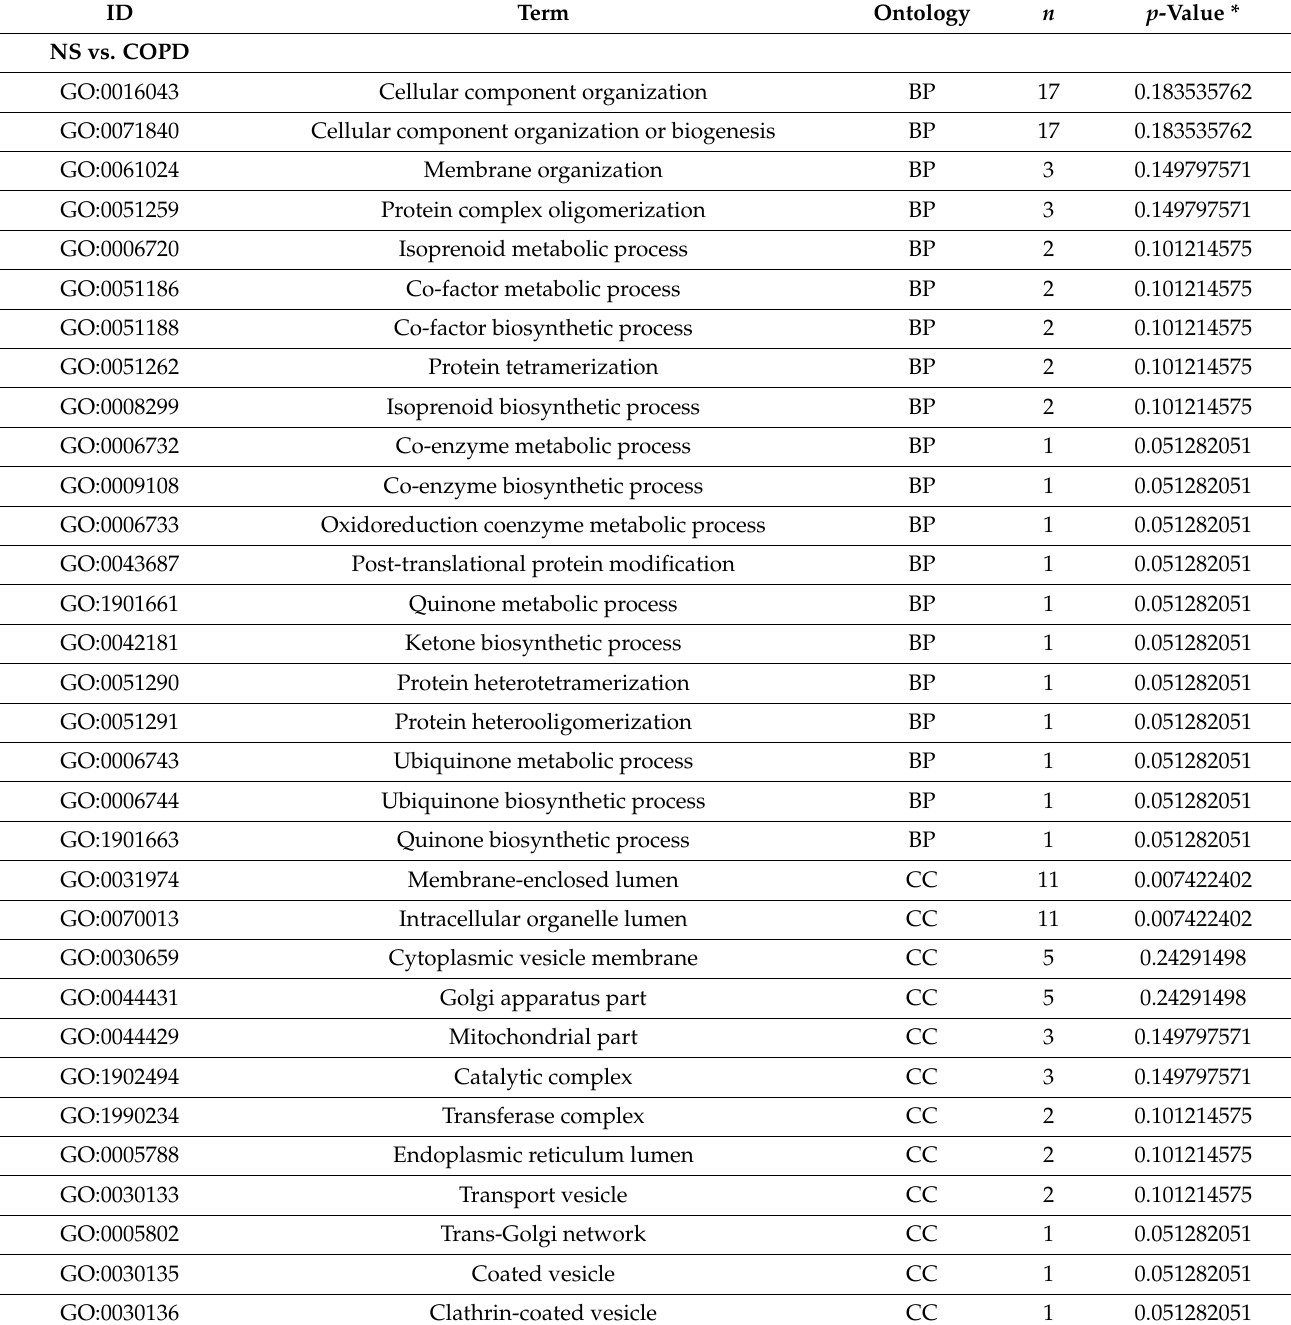
Table 1. GO enrichment analysis of differentially expressed miRNAs in BALF-derived